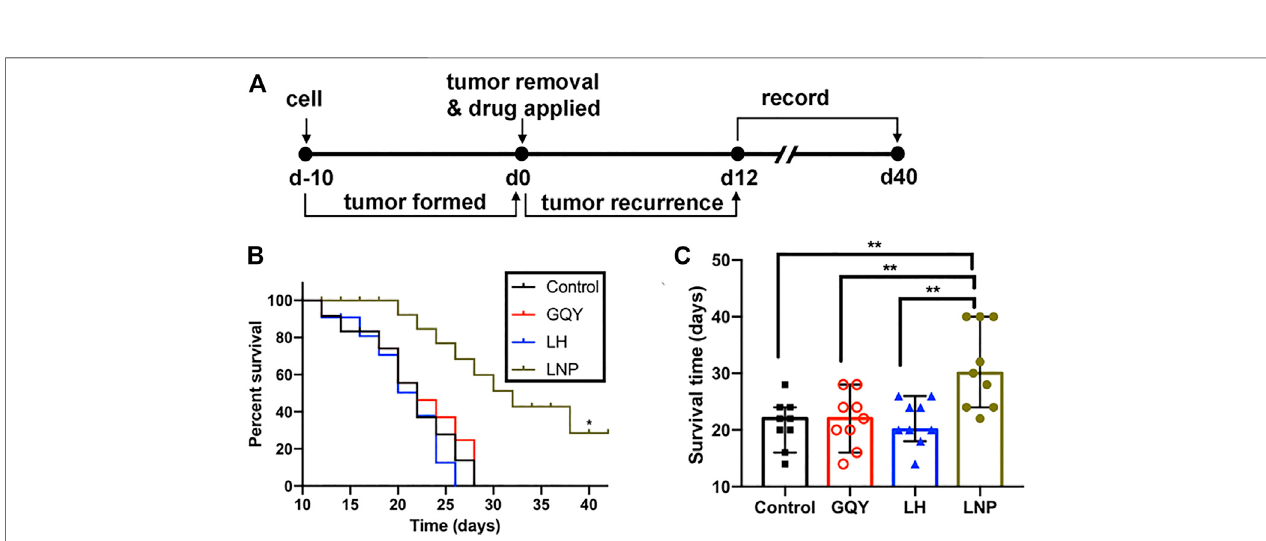
FIGURE 7 | (A) preformed tumors were partially excised and different formulations were injected on day 0, and the recurrence of tumors was monitored from day 12. (B) survival curve and (C) survival time were compared between different groups, determined based on a tumor volume of 1,500 mm 3 . ** p < 0.01 by one-way ANOVA with Tamhane ’ s T2 post-hoc